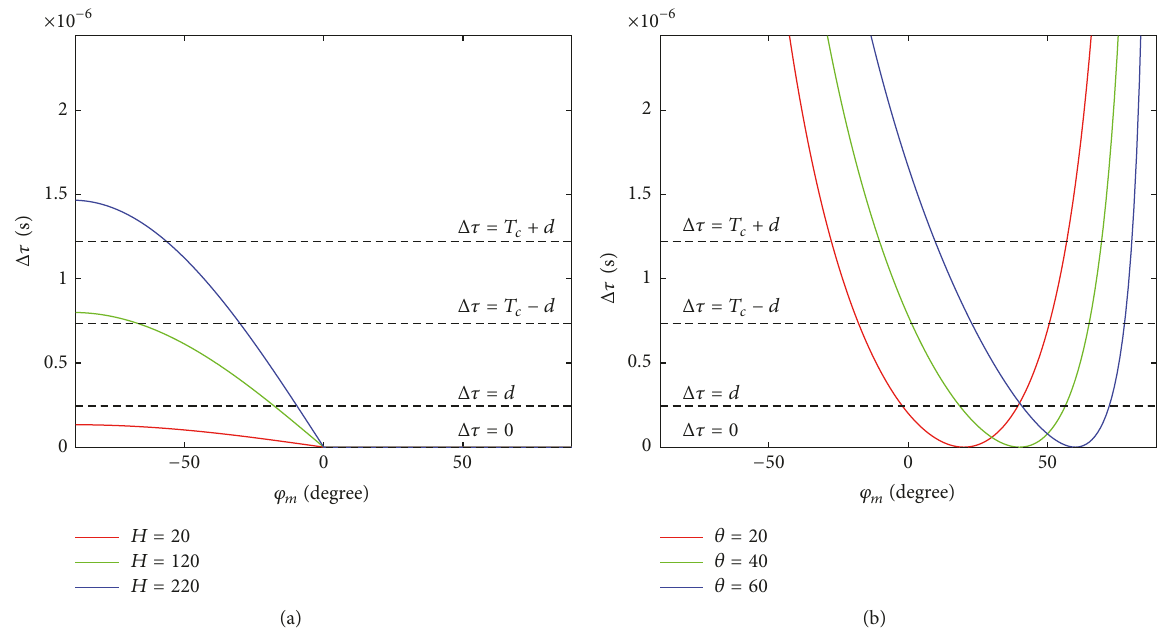
Figure 4: In this figure, the chip width 𝑇 𝑐 is set to 1/1.023𝑒6 as the chip width of C/A code in GPS, the early-late spacing of correlators is 𝑑 = 0.25𝑇 𝑆 𝑐 and the radius 0 of semiopen land is 1000m. (a) shows propagation time delays of multipath signals at horizontal surfaces with different antenna installation heights ( 𝐻 ). (b) shows delays at inclined surfaces with different satellite elevation angles ( 𝜃 ). Four horizontal dotted lines marked from top to bottom represent delay thresholds Δ𝜏 = 𝑇 𝑐 + 𝑑 , Δ𝜏 = 𝑇 𝑐 − 𝑑 , Δ𝜏 = 𝑑 , and Δ𝜏 = 0 . Only multipath signals with delays between the top two lines and the bottom two lines have impact on PPE.